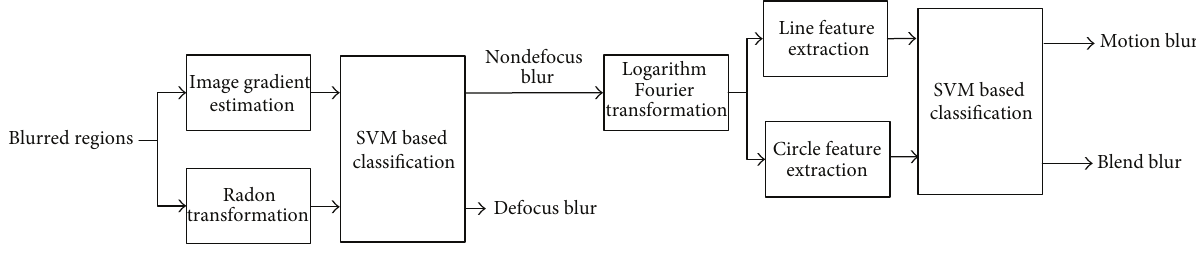
Figure 4: The flow chart of blur